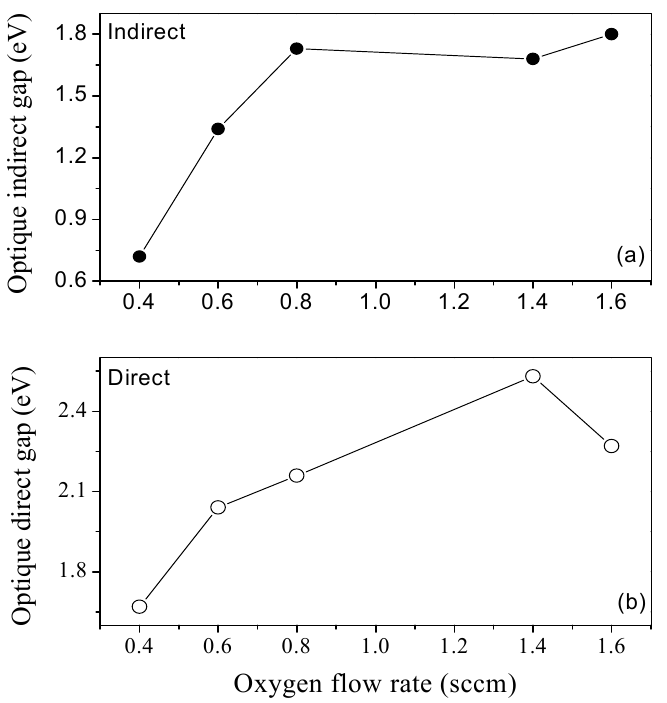
Figure 8. ( a ) Optical direct and ( b ) indirect gap for representative samples deposited with Q (N 2 ) = 8 sccm as a function of the oxygen flow.